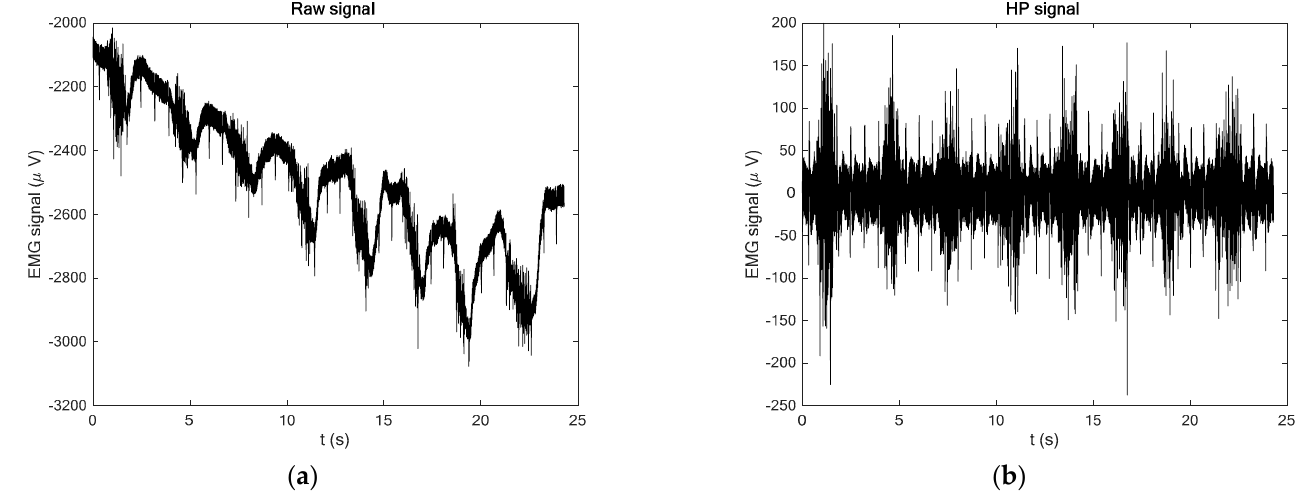
Figure 1. An example of the raw EMG signal of the right abdominal muscle with high impact of 50 Hz power line and ECG disturbances, ( a ) raw signal, ( b ) after removing low-frequency spectral range using 3rd order Butterworth HP filter, f c = 2 Hz.